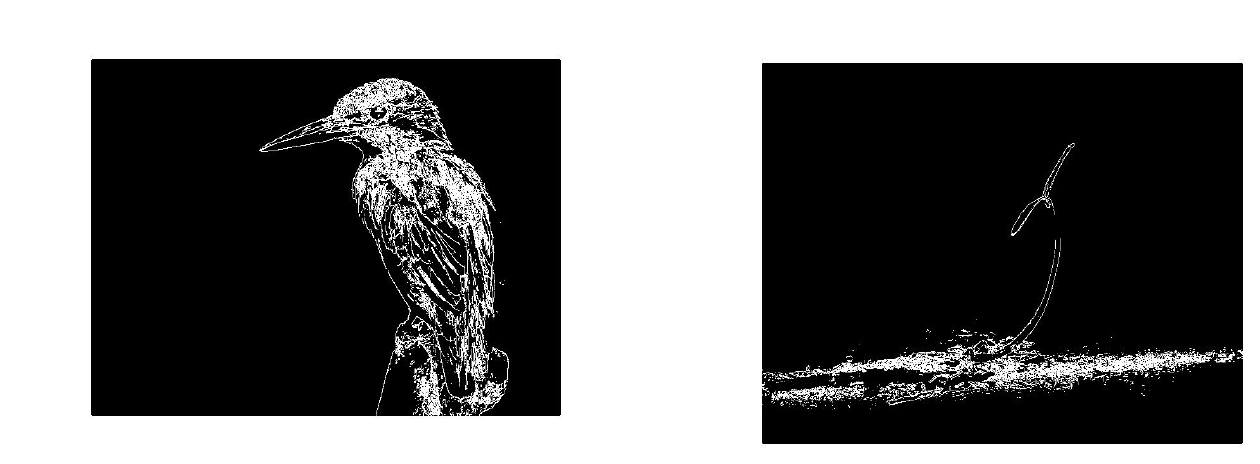
Figure 7.2 Segmented Plant Image